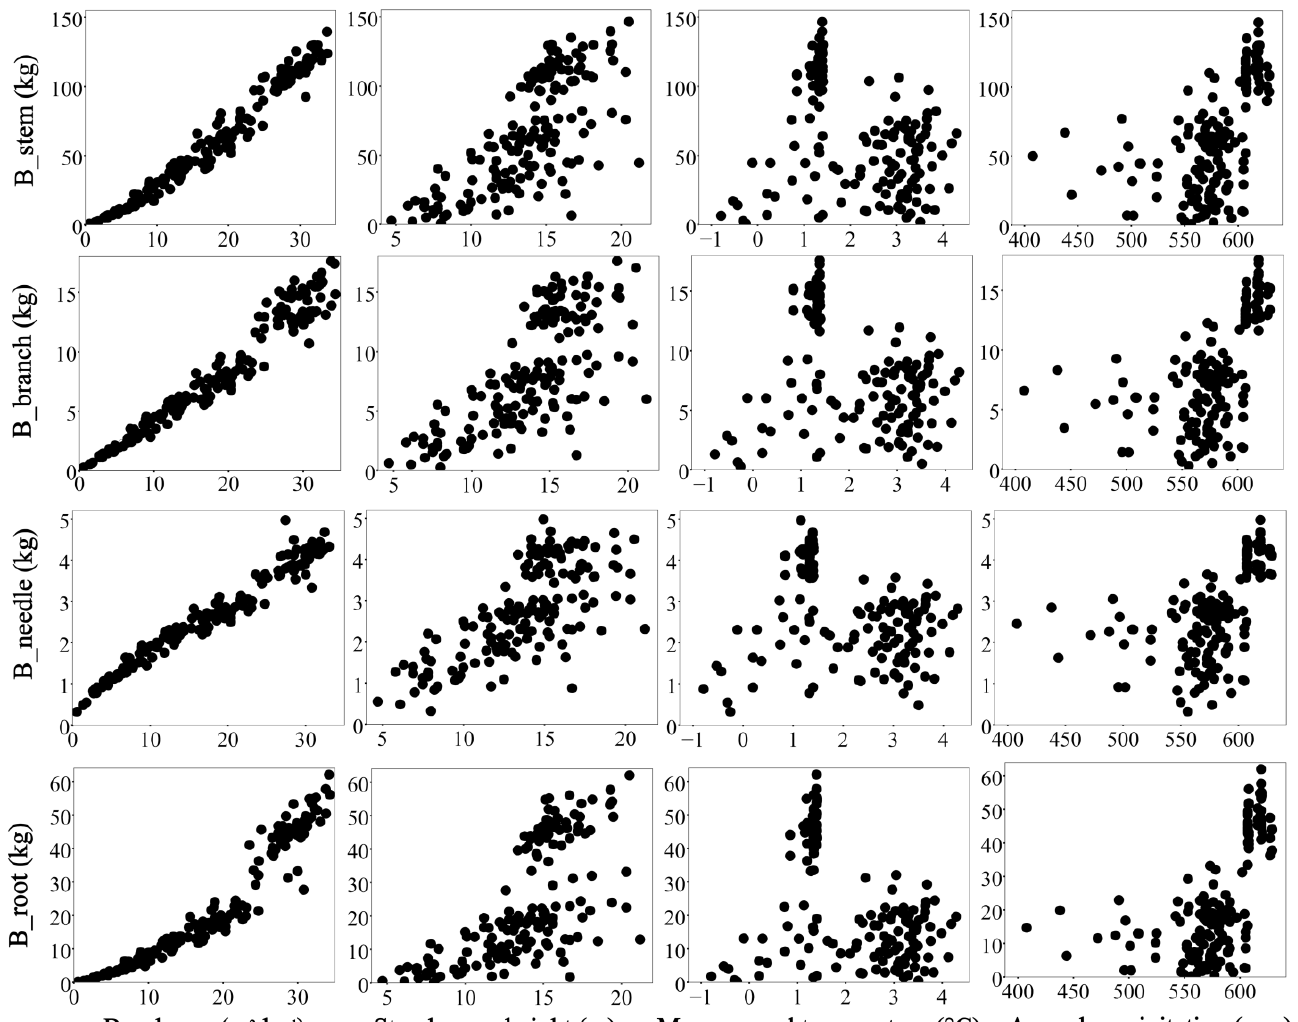
Figure 1. Scatter plot of the component biomass (B_stem, B_branch, B_needle, and B_root), as opposed to the basal area (BA), stand mean height (Hm), mean annual temperature (MAT), and annual precipitation (AP).